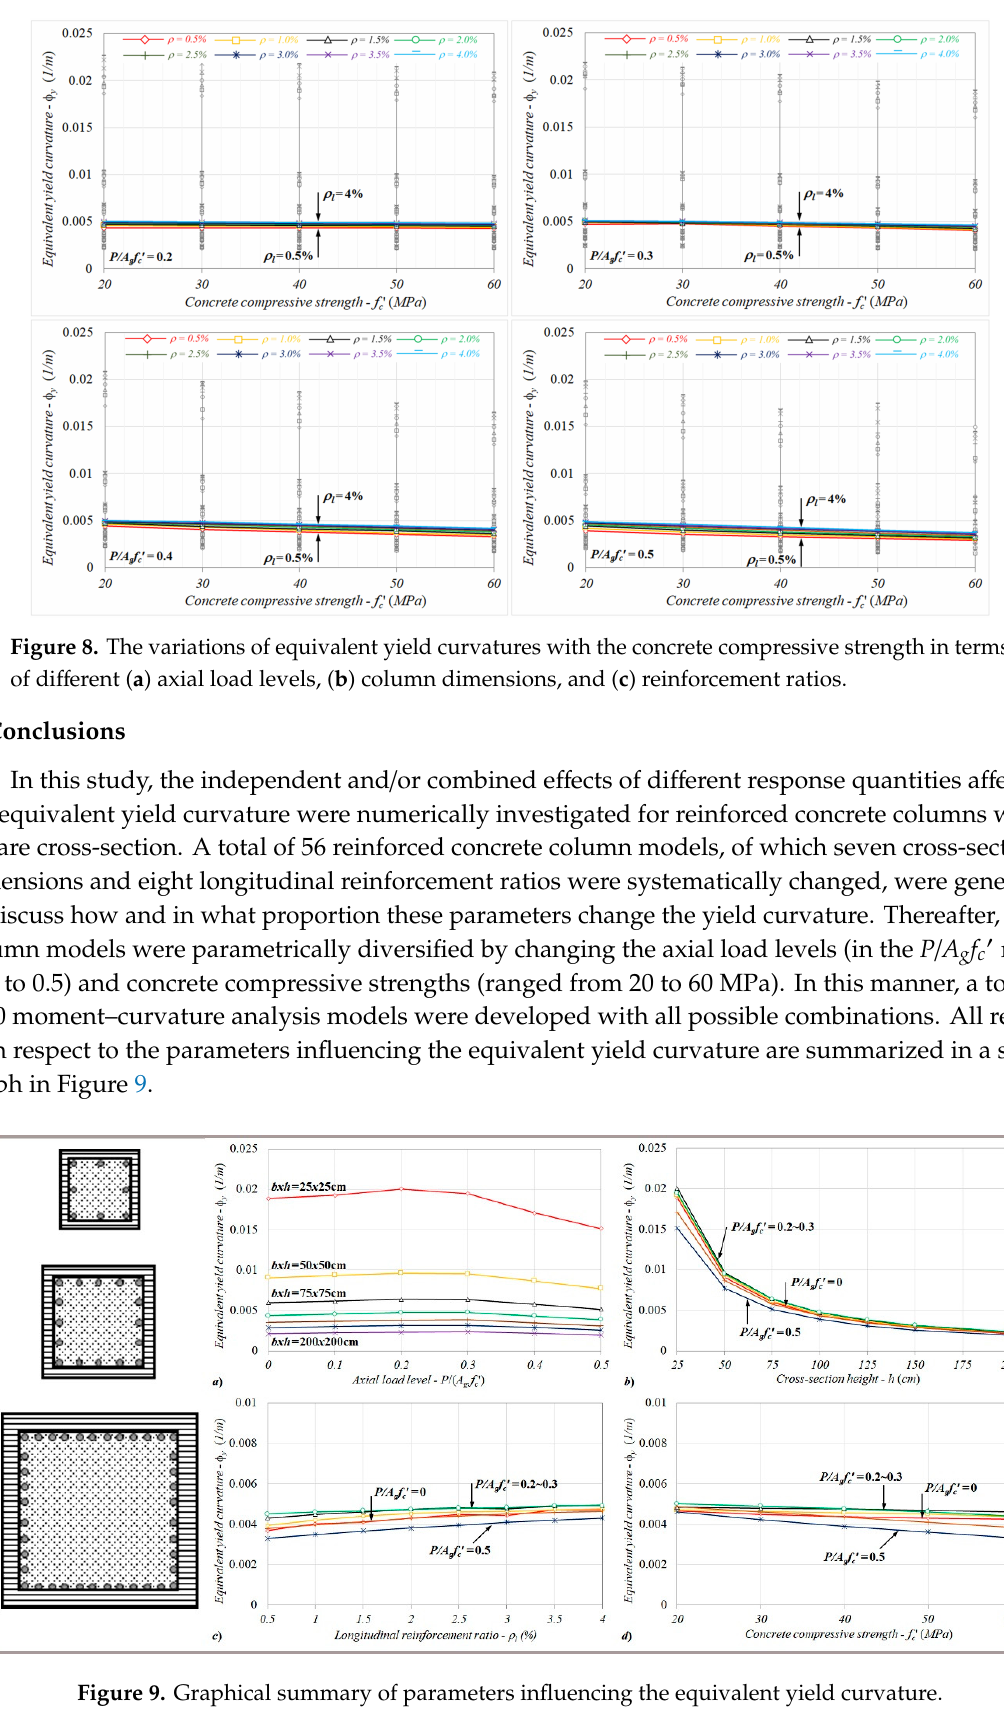
Figure 9. Graphical summary of parameters influencing the equivalent yield curvature.